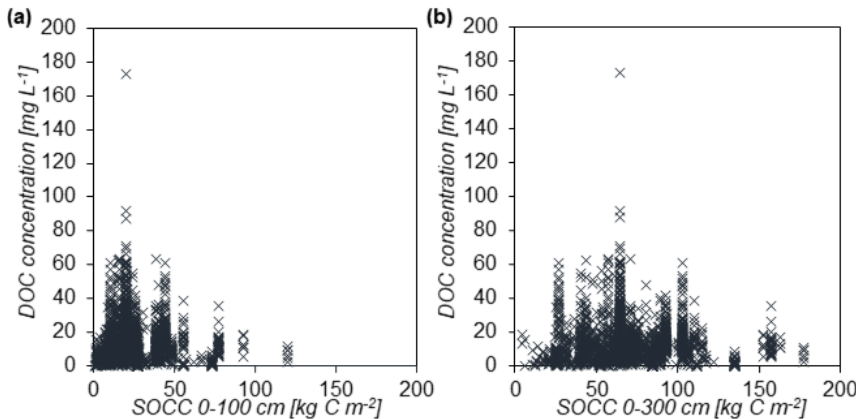
Figure 4. Scatterplots for lake DOC concentration and lake-surrounding soil organic carbon content (SOCC) at a depth of 0 to 100cm (a) and at a depth of 0 to 300cm (b) . To better visualize the relationship of both parameters, we limited the y axis to 200mgL − 1 . Three lakes with DOC concentrations of 433, 507, and 1130mgL − 1 and SOCC of 19.7kgCm − 2 at a depth of 0–100cm and 64.6kgCm − 2 at a depth of 0–300cm are not included in this